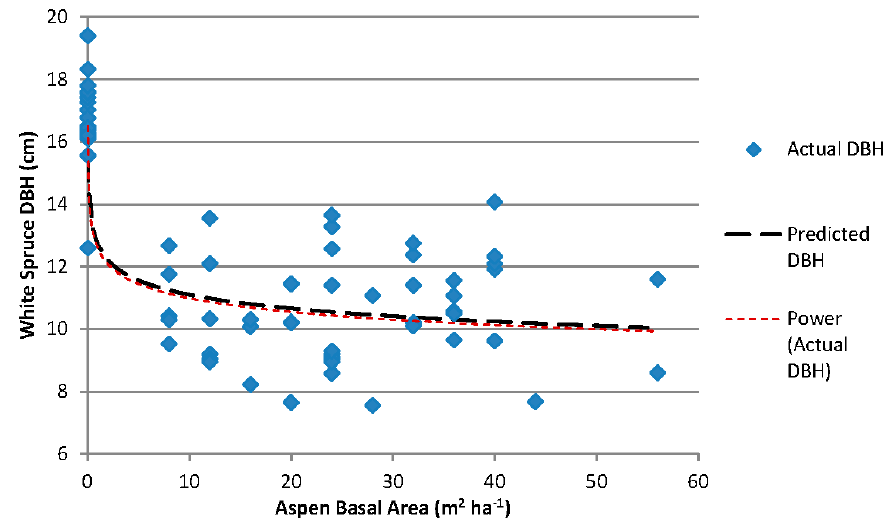
Figure 1. Relationship between white spruce dbh (four largest diameter spruce in each subplot) and measured aspen basal area for the Siphon Creek study area. The model used for the relationship is Y = bX c .